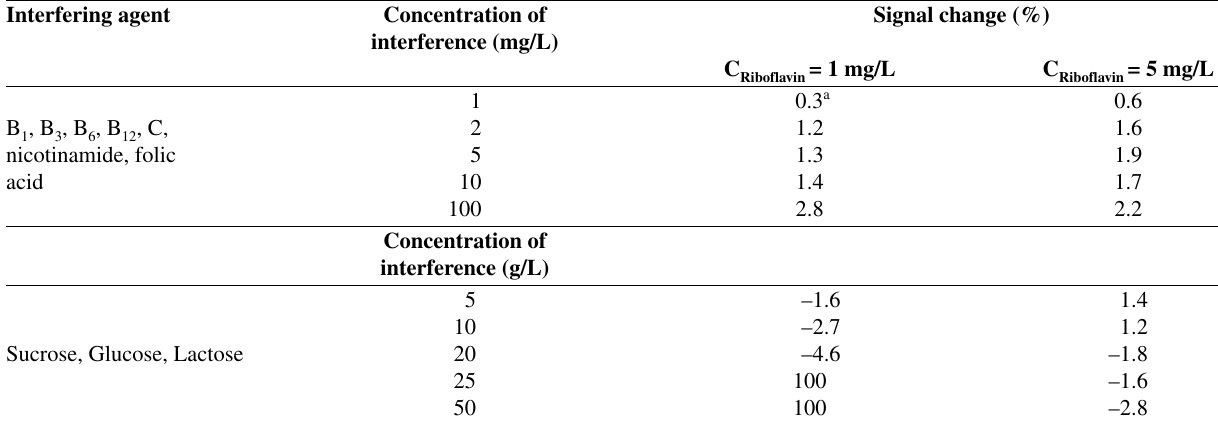
Table 2. Influence of potential interfering substances on the riboflavin analytical signal Interfering agent Concentration of Signal change